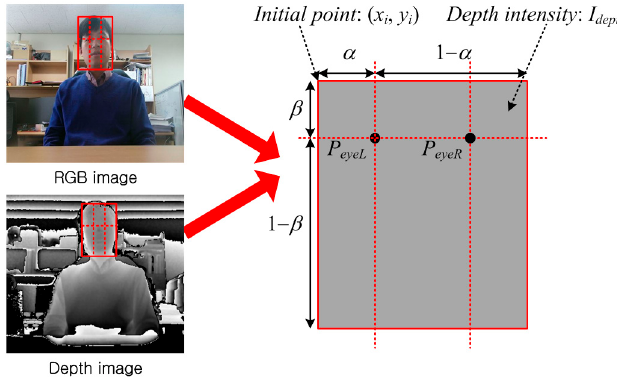
Figure 7. Concept for extracting 3D eye position from the RGB and depth images.